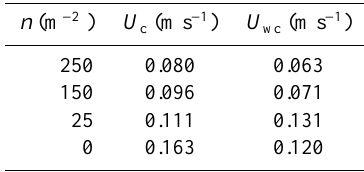
Table 3. Measured critical velocities for currents, U c , and critical orbital velocities, U wc , according to the measurements of suspended sediment concentration at z = 0 . 05m for all densities at x c = 3m.